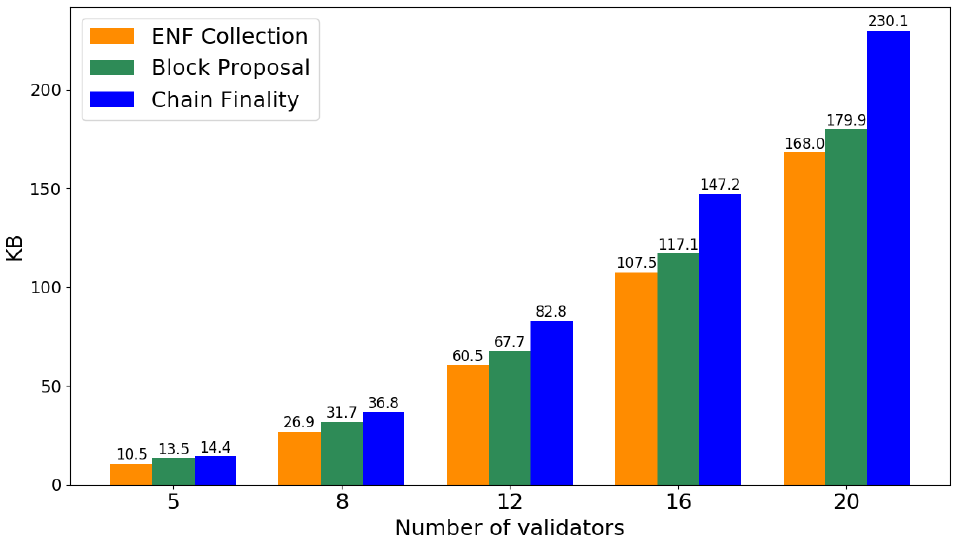
Figure 6. Communication overhead of running an epoch round of PoENF consensus. Comparative evaluations on different committee size.